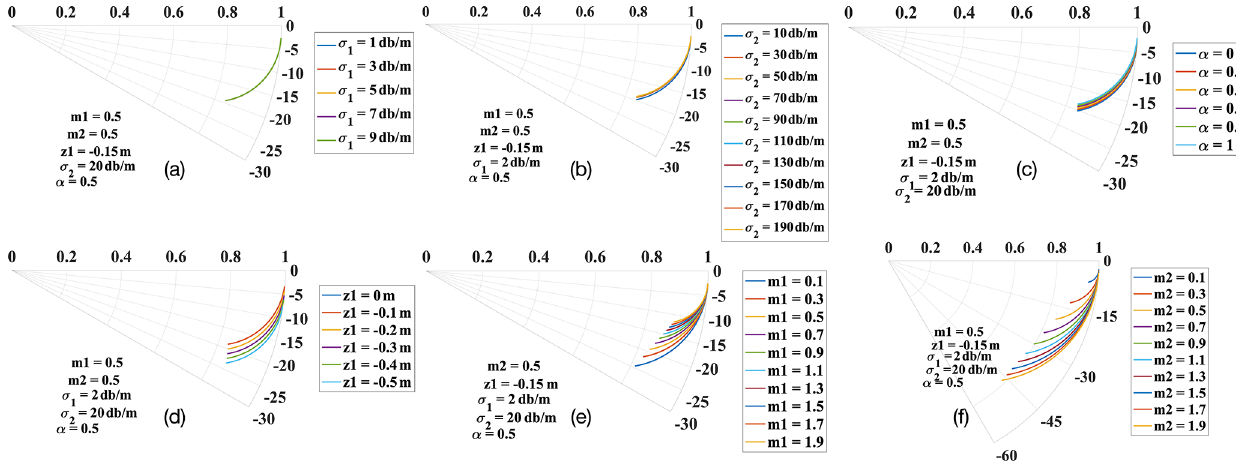
Figure 8. Simulation of ˜ γ mod_T for the proposed model by varying (a) snow extinction σ 1 , (b) ice extinction σ 2 , (c) weight parameter α , (d) top-layer position z 1 , (e) top-layer layer-to-volume ratio m 1 , and (f) bottom-layer layer-to-volume ratio m 2